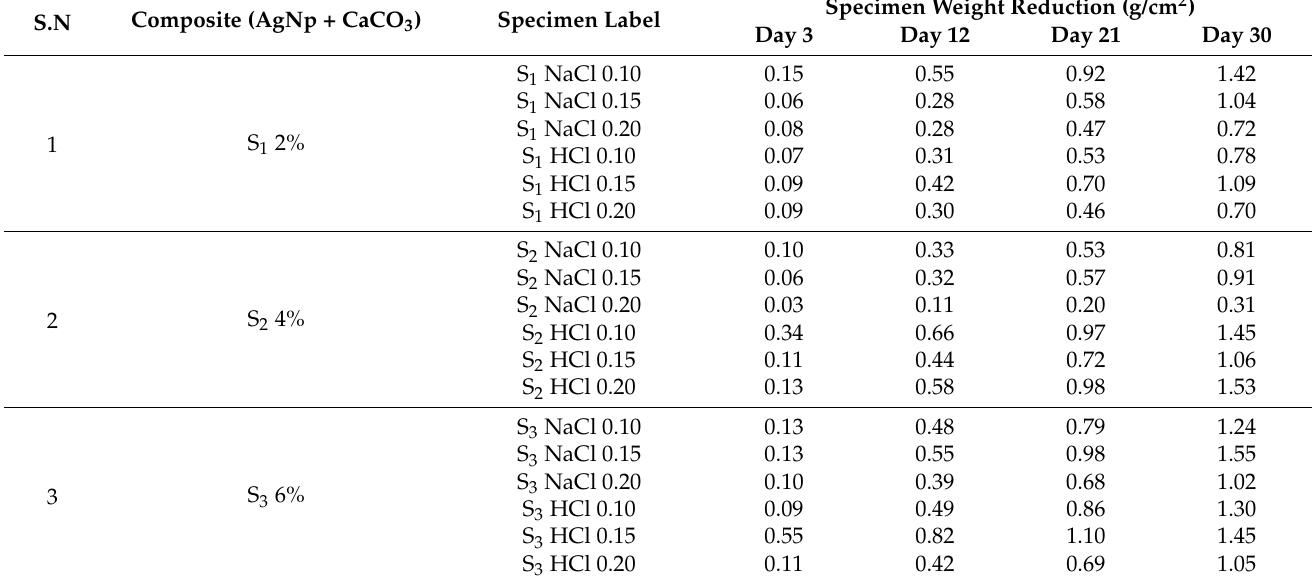
Table 7. Specimens S 1, S 2 and S 3 weight reduction in HCl and